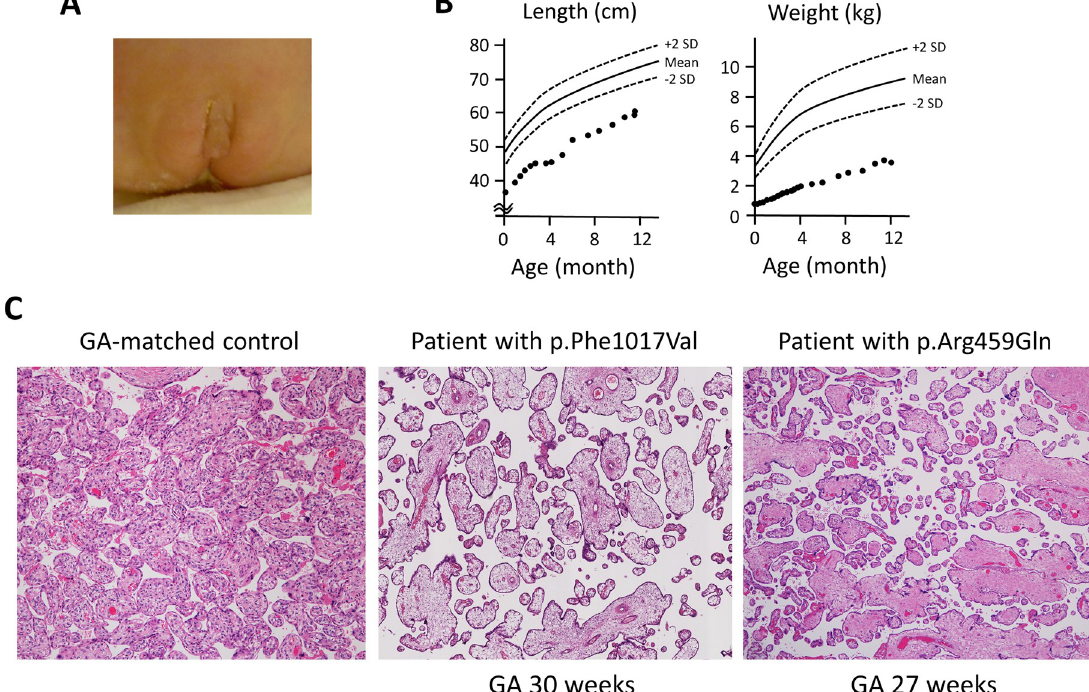
Fig 4. Clinical findings of the patient with the p.Phe1017Val variant. A, The patient had significant undervirilization, and the sex of rearing was assigned to female. B, Growth restriction was observed in both prenatal and postnatal life (postnatal growth plotted here). C, Histological evaluation of the placental tissue derived from two SAMD9 variant carriers (p.Phe1017Val and p.Arg459Gln) was performed with hematoxylin eosin staining. The two specimens commonly showed sparse, poorly developed distal villous tree with widening of the intervillous